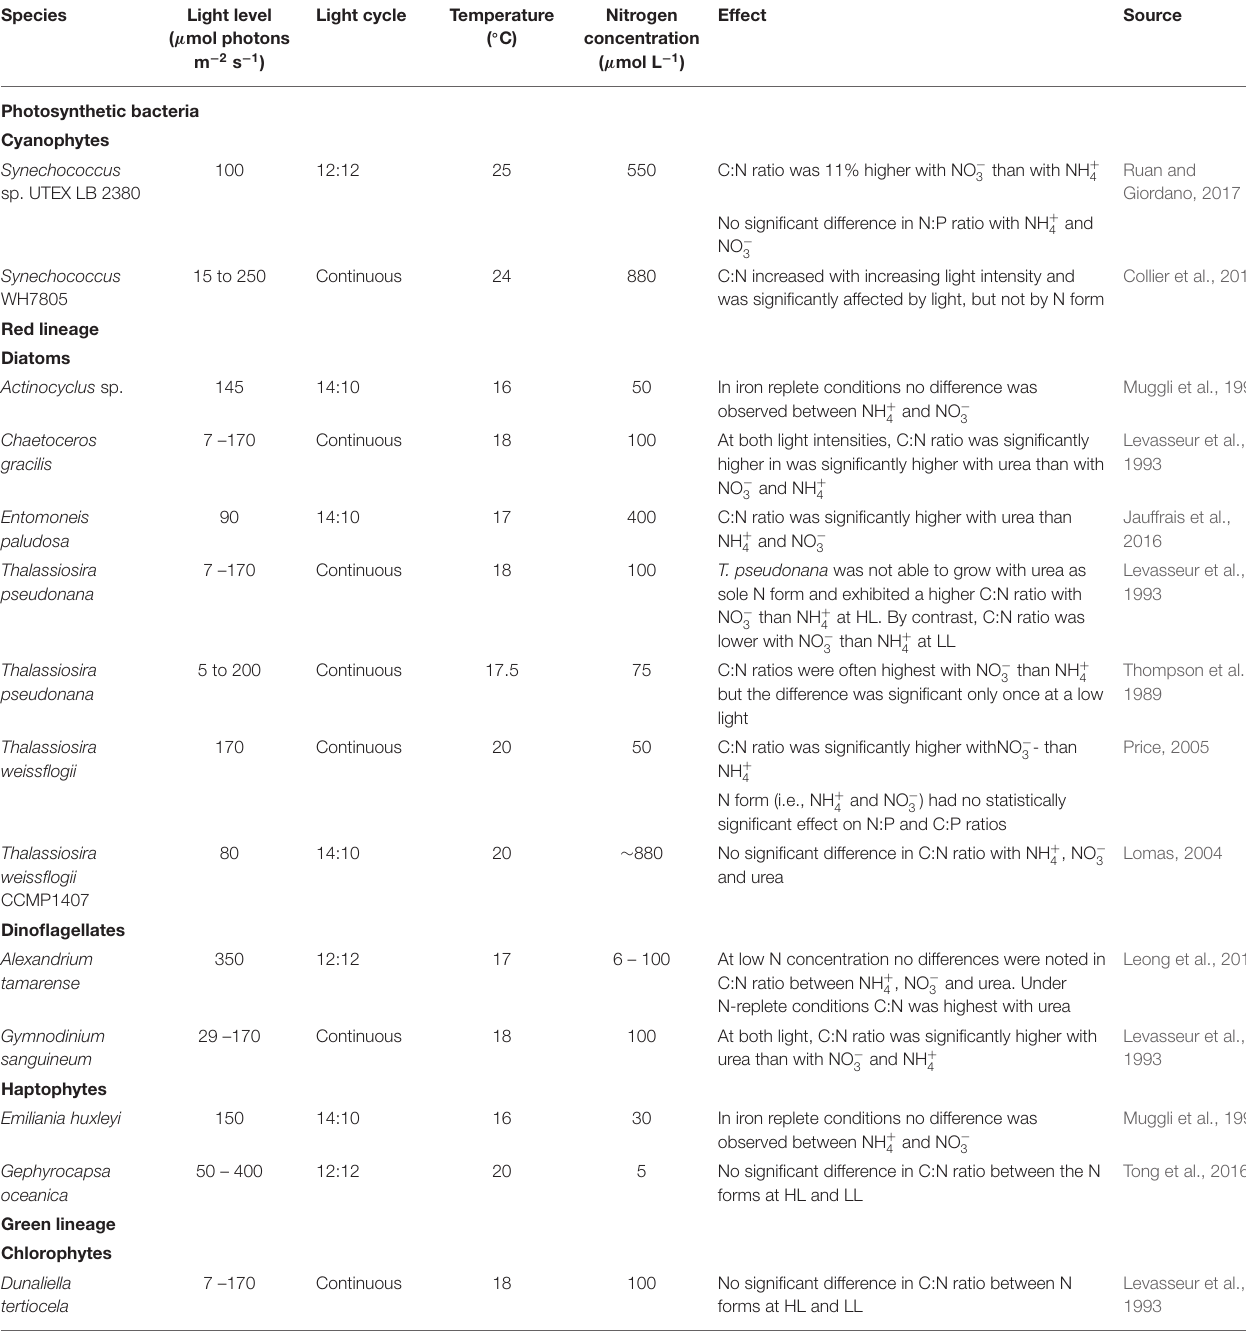
TABLE 3 | Summary of published studies on the effect of different N forms on the elemental stoichiometry of phytoplankton.